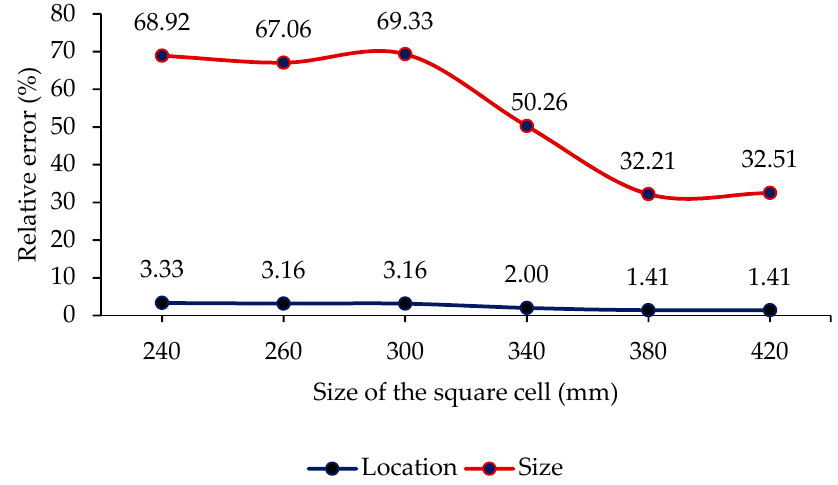
Figure 10. E ff ect of the detection cell size on the accuracy of the results. Figure 10. Effect of the detection cell size on the accuracy of the results.